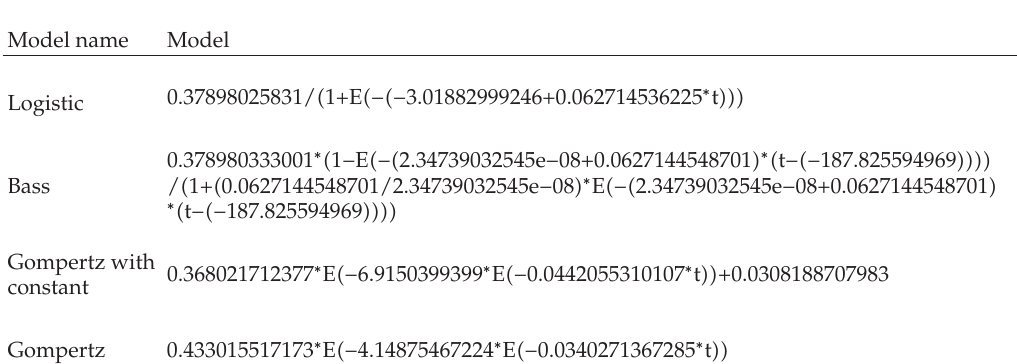
Table 34: Representation of the optimized di ff usion models in forecasting (cid:2) The Netherlands (cid:3) . Forecasting performance—optimized di ff usion models for The